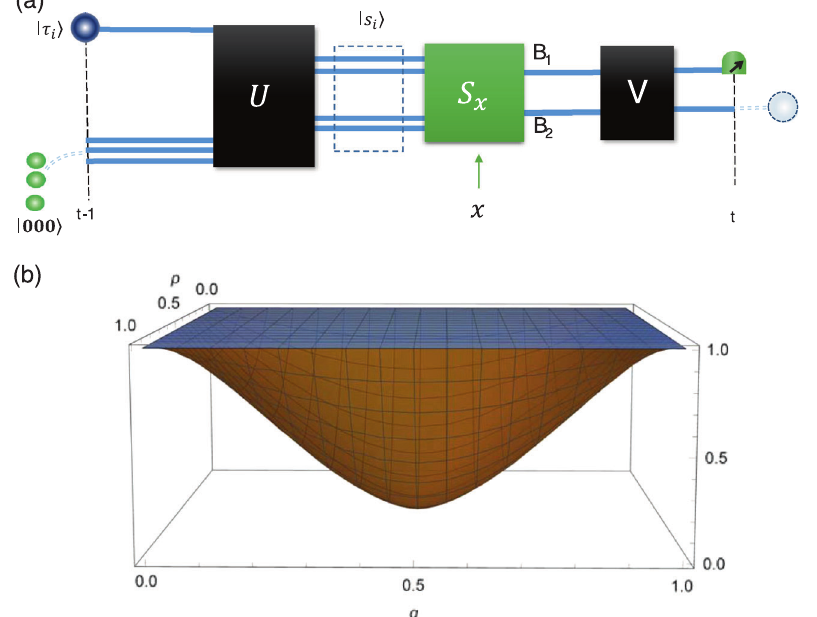
Fig. 4 The quantum transducer for the perturbed coin can generate appropriate future statistics via the quantum circuit in a . Suppose a transducer, in state | τ i 〉 , receives input x at time t . To generate output y , it transforms | τ i 〉 to a 4-qubit quantum state | s i 〉 by application of an appropriate unitary U on | τ i 〉 and three ancilla qubits in state | 000 〉 . The transducer then discards qubits one and two if x = 0, or qubits three and four if x = 1. The two remaining qubits, labeled B 1 and B 2 , are subsequently transformed by a unitary V that maps | 00 〉 to 0 τ 0 j i and | 11 〉 to 1 τ 1 j i (this is always possible as h 0 τ 0 j 1 τ 1 i¼ 0 ). B 1 is emitted as output while B 2 is retained by the transducer as the causal state for the subsequent time-step. Measurement of B 1 in the computational basis yields y . Iteration of this procedure replicates correct future input – output statistics. The resulting improved ef fi ciency is highlighted in b , which depicts the maximum memory required by a quantum transducer Q ( orange surface) to simulated the actively perturbed coin vs. its classical counterpart, the structural complexity C ( blue surface) for various p and q . While the ε -transducer generally requires 1 bit of memory, the quantum transducer requires less, and becomes increasingly more ef fi cient as p , q →